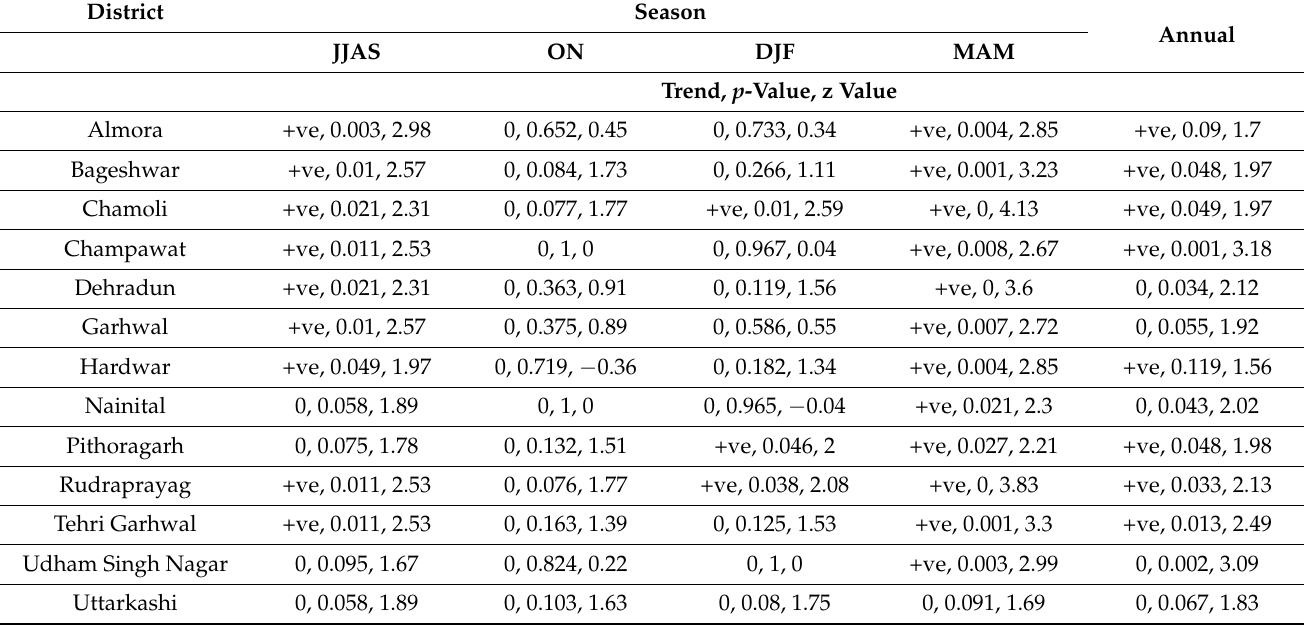
Table 4. The trend analysis of seasonal and annual rainfall for each